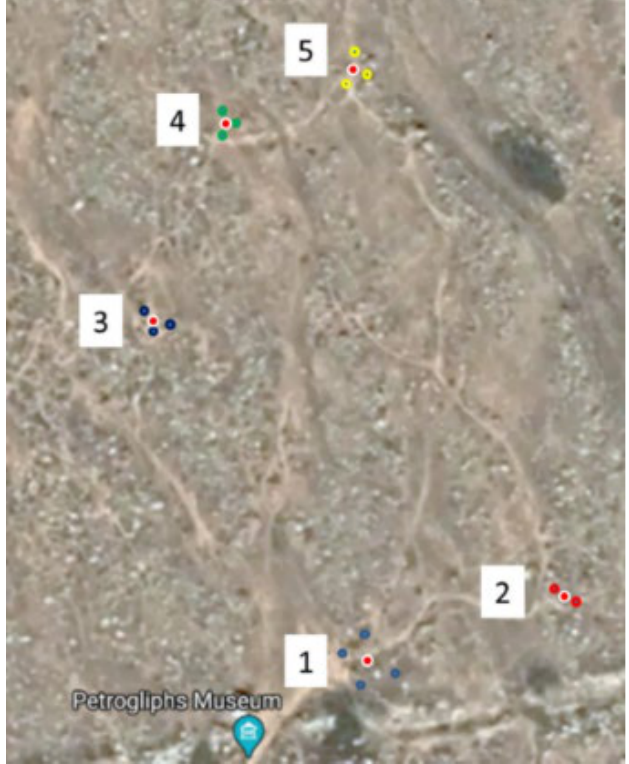
Figure 8. Arrangement of petroglyphs and assigned scan positions (coloured points around the positions of objects—marked with red dots with white halo). Source: own study with the use of Google Maps.